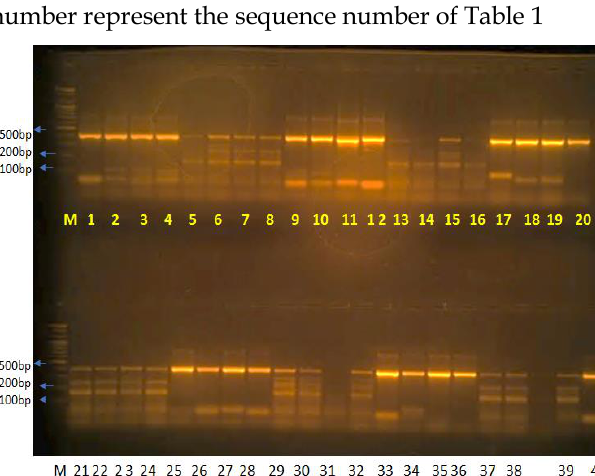
Figure 3. SSR profiles of 40 finger millet landraces amplified by UGEP-10 primer. M, 100 bp ladder and lane number represent the sequence number